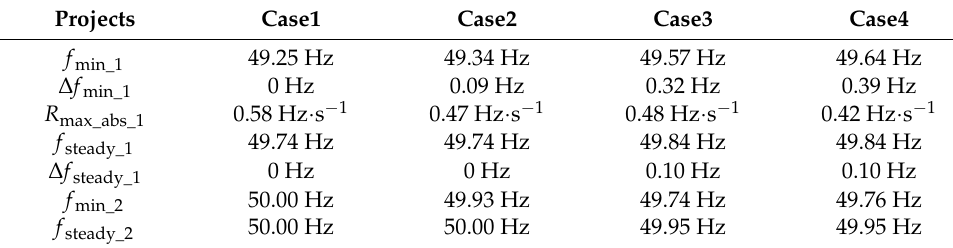
Figure 11. System frequency under different control modes (sudden load increase). ( a ) The frequencies of the sending-end system; ( b ) the RoCoF of the sending-end system; ( c ) the actual power transmitted by the UHVDC; ( d ) the frequencies of the receiving-end system; ( e ) the RoCoF of the receiving-end system. Table 2. Results under different frequency control modes (sudden increase in